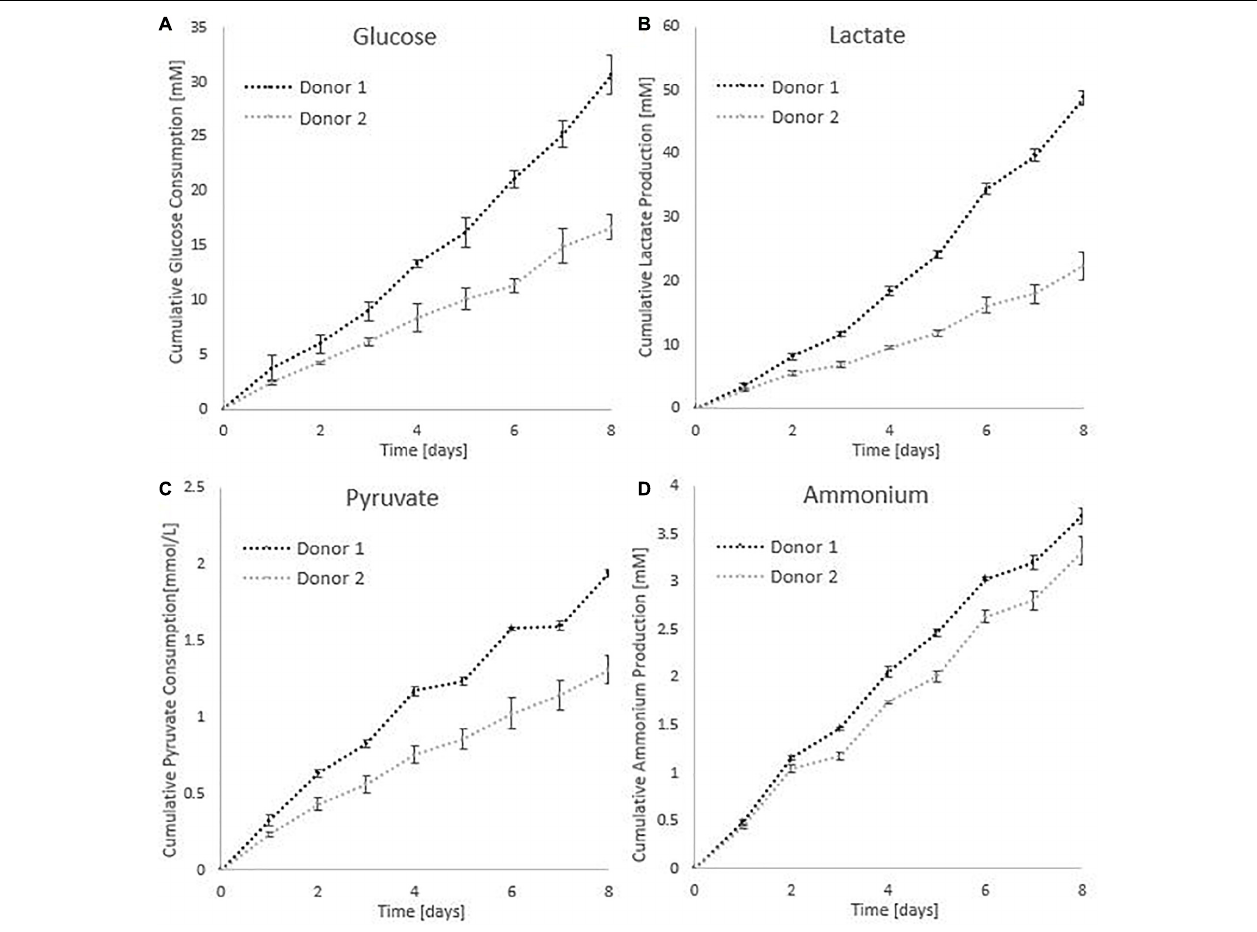
FIGURE 8 | Metabolic profiles for the dynamic Star-Plus evaluation for an average of the triplicate spinners for each of the donors. (A) Cumulative glucose measurements, (B) cumulative lactate measurements, (C) pyruvate measurements, and (D) ammonium measurements.